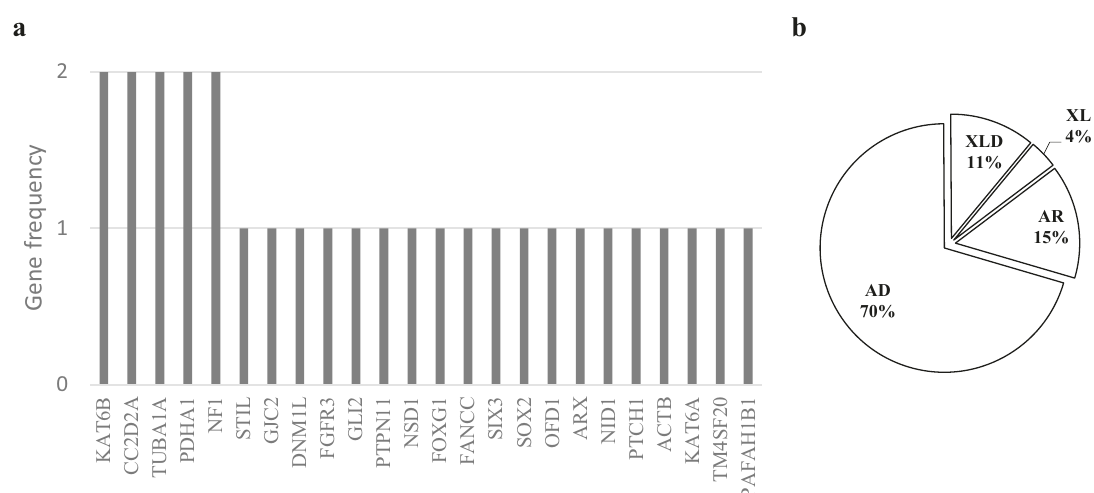
Fig. 2 Critical genes identi fi ed in diagnosed cases and gene-related inheritance patterns. a Frequency of genes with diagnostic variants or critical genes in diagnostic CNVs. b Percentage of inheritance modes of diseases associated with genes in ( a ), AR autosomal recessive, AD autosomal dominant, XLD X-linked